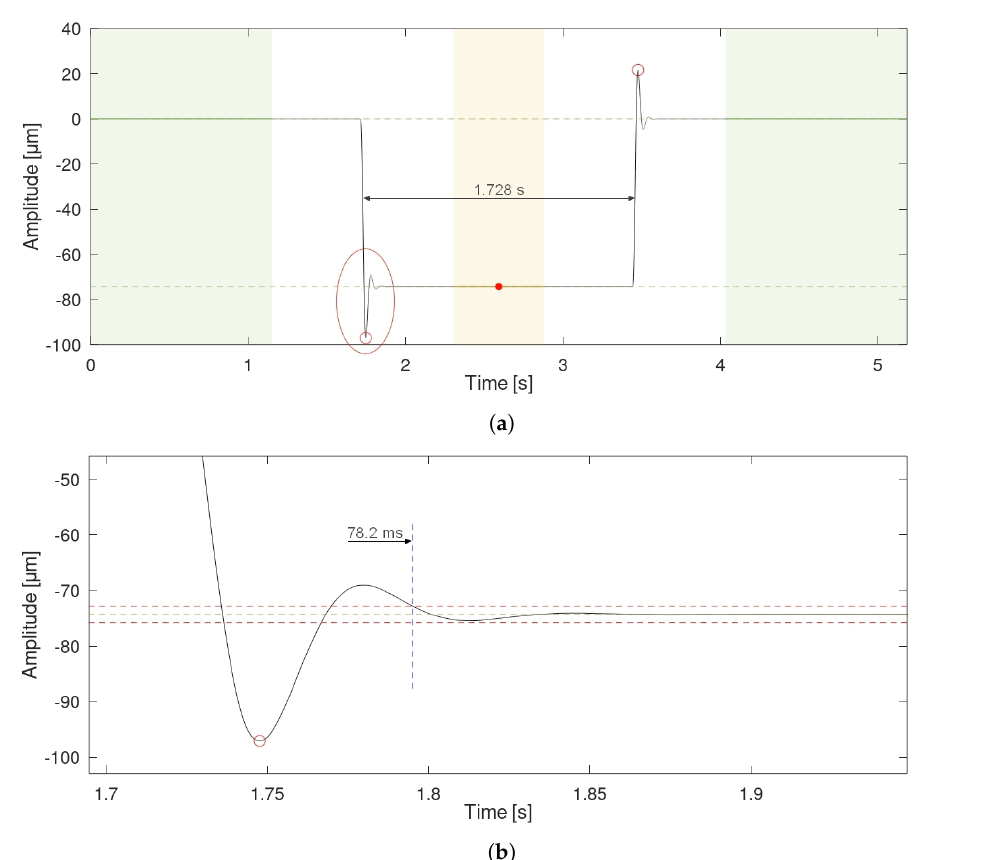
Figure 5. ( a ) Example of ringing oscillations observed in the simulated groove of 75 µ m. The green dashed lines represent the model fitted according to ISO 5436-1:2000 standard. These lines are extrapolated along the time axis for visual guidance. The red ellipse indicates the zoomed-in area shown below. Small red circles indicate peaks of the oscillations: 22.8 µ m for the falling edge and 21.9 µ m for the rising edge respectively. Green-shaded areas are placed over external measurement lengths and the orange-shaded area is placed over the central measurement length. The red dot indicates the middle of the central length; ( b ) Zoomed-in oscillations at the falling edge of the groove. Red horizontal lines represent 2% deviation from the target depth. The blue vertical line represents the end of the settling time. The settling time equals 78.2 ms.